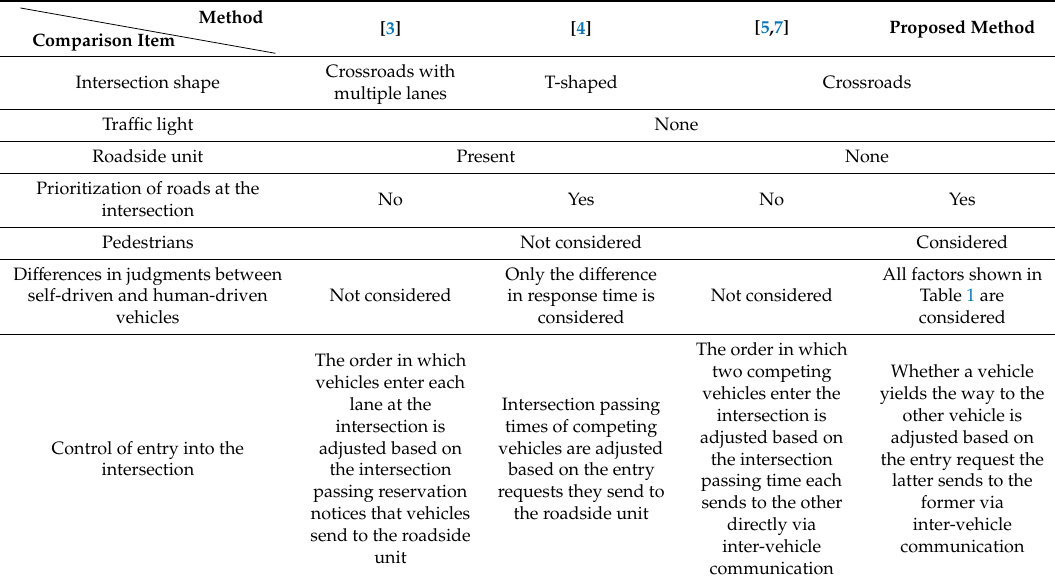
Table 2. Comparison of methods of controlling the tra ffi c of both self-driven and human-driven vehicles. Comparison Item